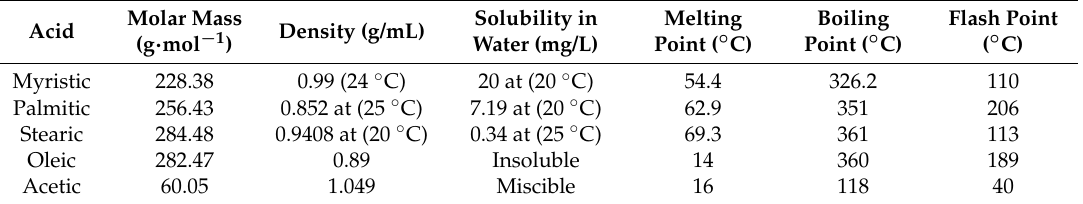
Table 3. Physicochemical properties of the used acid compounds in the biodiesel